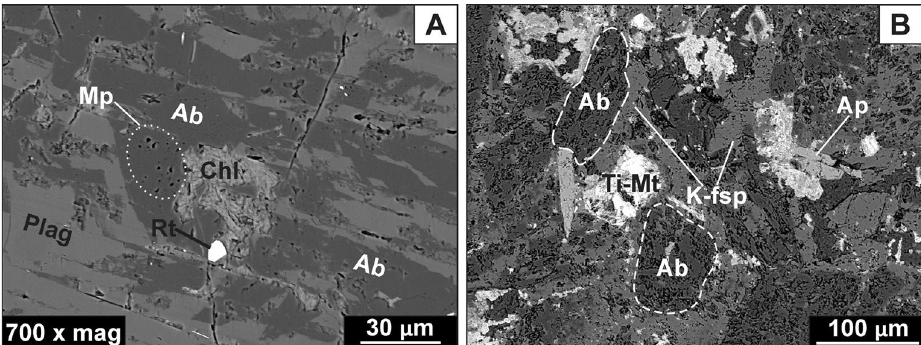
Figure 7. SEM-BSE images showing albitization in trachyandesites from Głuszyca. ( A ) Partial albitization of primary plagioclase (andesine-labradorite) followed by the formation of minor rutile; note the secondary albite do not contain any visible cogenetic inclusions except for chlorite that could precipitate in voids (Loc. 1); ( B ) Complete albitization of andesine-labradorite (Loc. 3); Note the presence K-feldspar surrounding albitized andesine-labradorite, as well as abundant micron-sized micropores developed within the secondary albite.